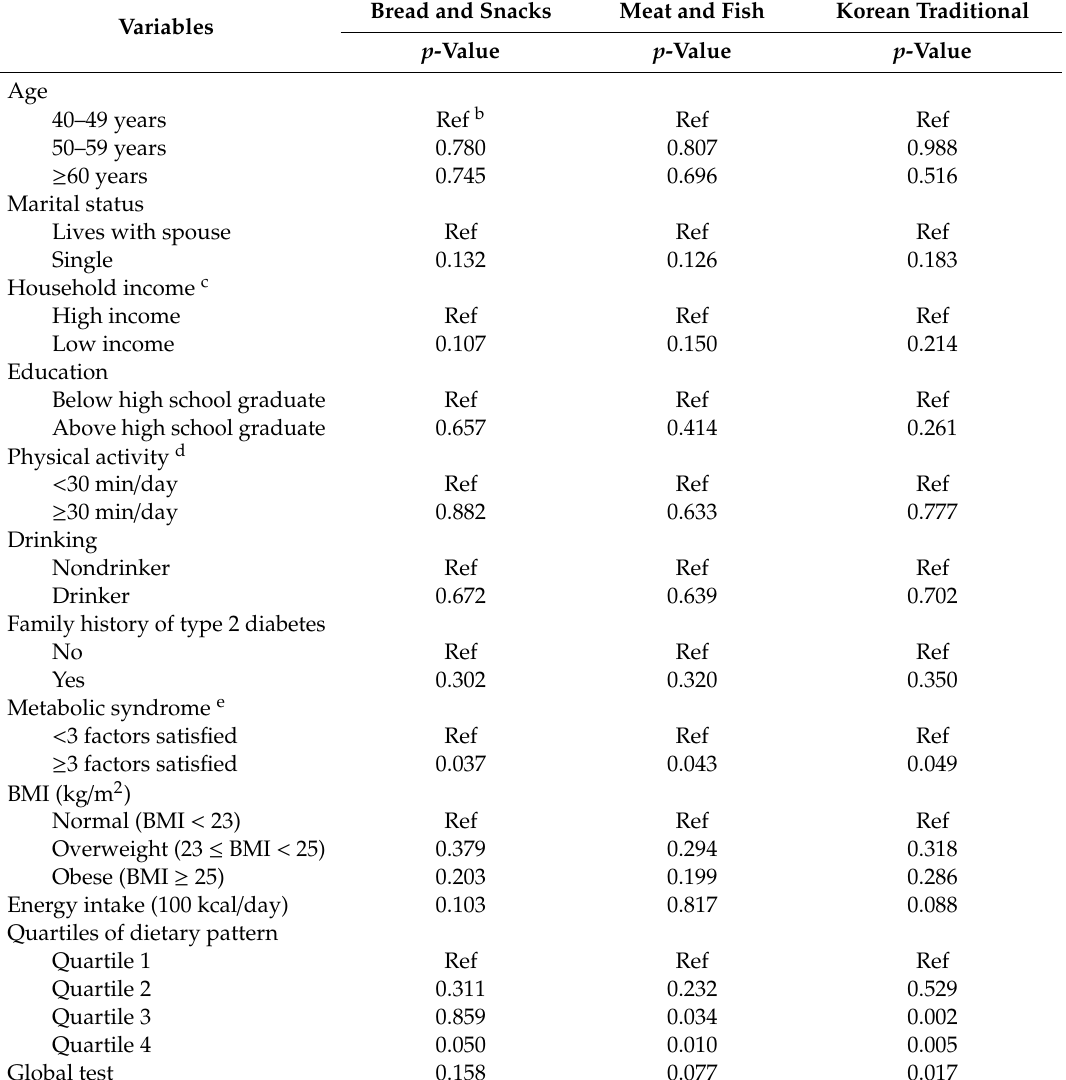
Table 4. Proportional hazards assumption test a in multivariable Cox